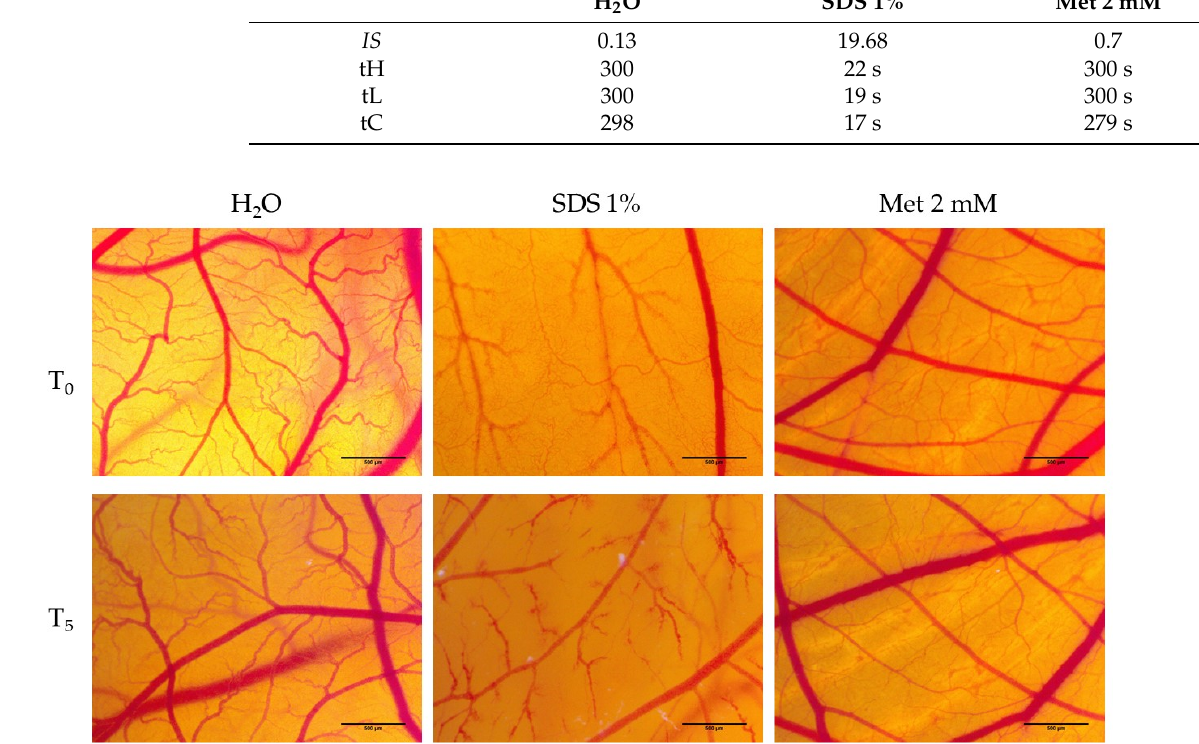
Figure 8. Analysis of the irritant potential of Met at concentration of 2 mM by the HET-CAM method. Stereomicroscopic images of CAMs inoculated with negative control—H 2 O, positive control—SDS and test compound—Met 2 mM.